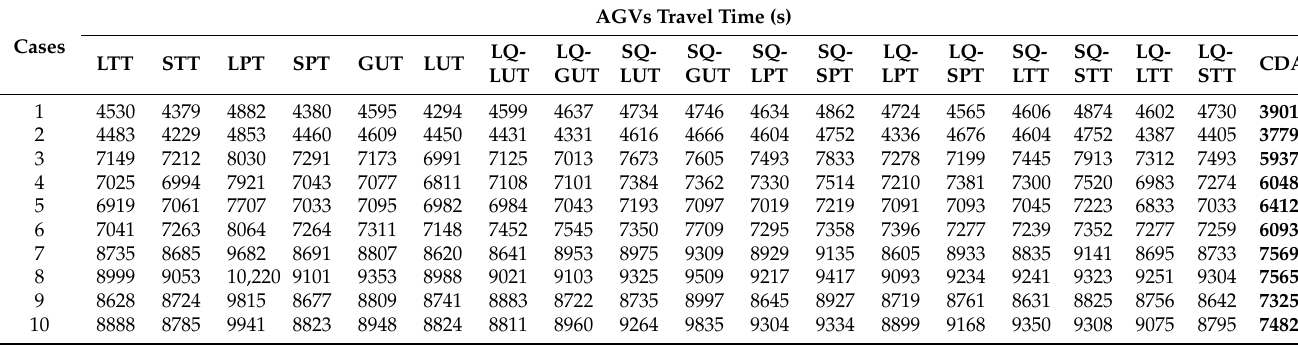
Table A3. AGVs travel time of CDA algorithm and assignment rules under different cases.